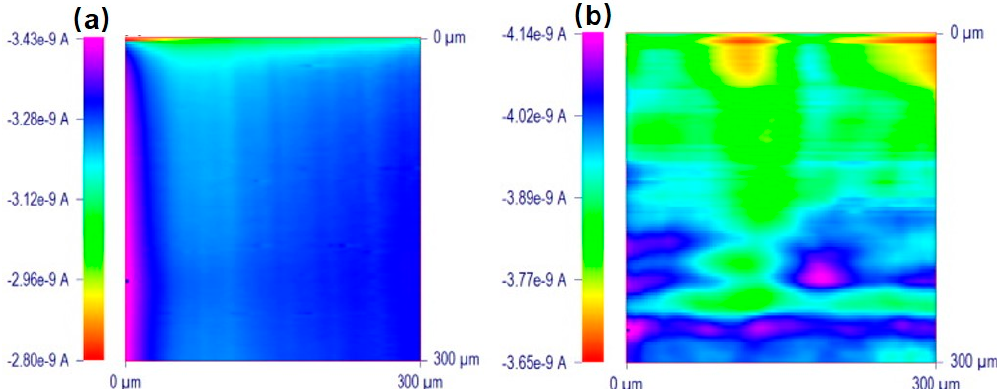
Figure 11 . SECM 2D images obtained with a platinum microelectrode (a = 5 μ m) in 1 mmol L − 1 of Figure 11. SECM 2D images obtained with a platinum microelectrode (a = 5 µ m) in 1 mmol L − 1 of Fe(CN) 63 − /4 − in the presence 10 -1 mol L − 1 of KCl for a substrate consisting of 11-mercaptoundecanoic Fe(CN) 6 3 − /4 − in the presence 10 − 1 mol L − 1 of KCl for a substrate consisting of 11-mercaptoundecanoic acid (1 mmol L − 1 ) ( a ) and consisting of antigen (50 μ g mL − 1 ) immobilized on self-assembled acid (1 mmol L − 1 ) ( a ) and consisting of antigen (50 µ g mL − 1 ) immobilized on self-assembled monolayers ( b ). Copyright (2013) Elsevier Ltd. monolayers ( b ). Copyright (2013) Elsevier